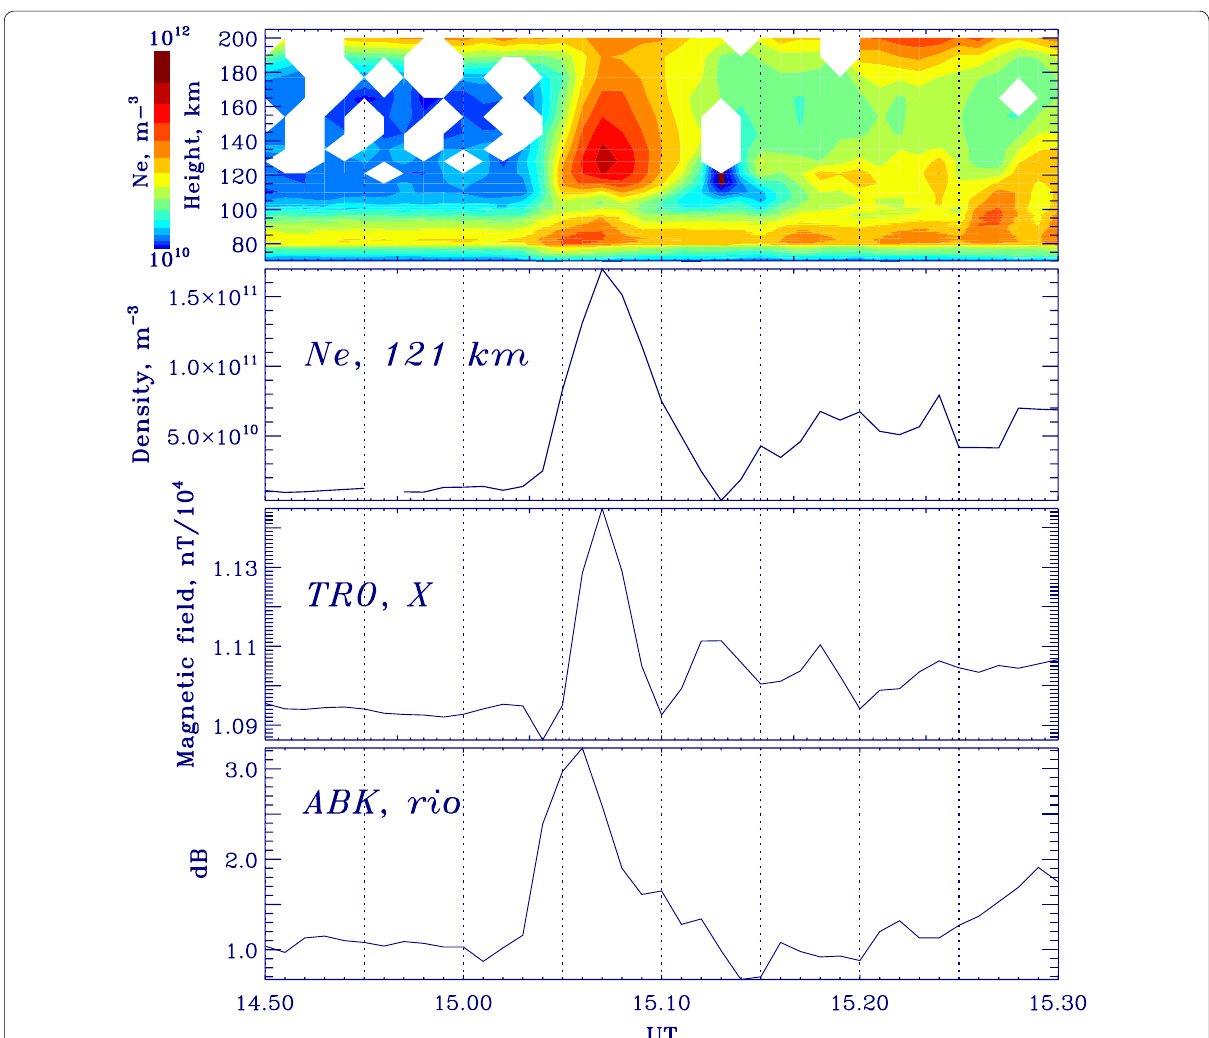
Fig. 13 Ionospheric and geomagnetic observations during January 24, 2012, at 1430–1530 UT (from top to bottom ): altitude distribution of electron density N e variations measured by EISCAT; variations of N e at altitude z riometer variations (in dB) at